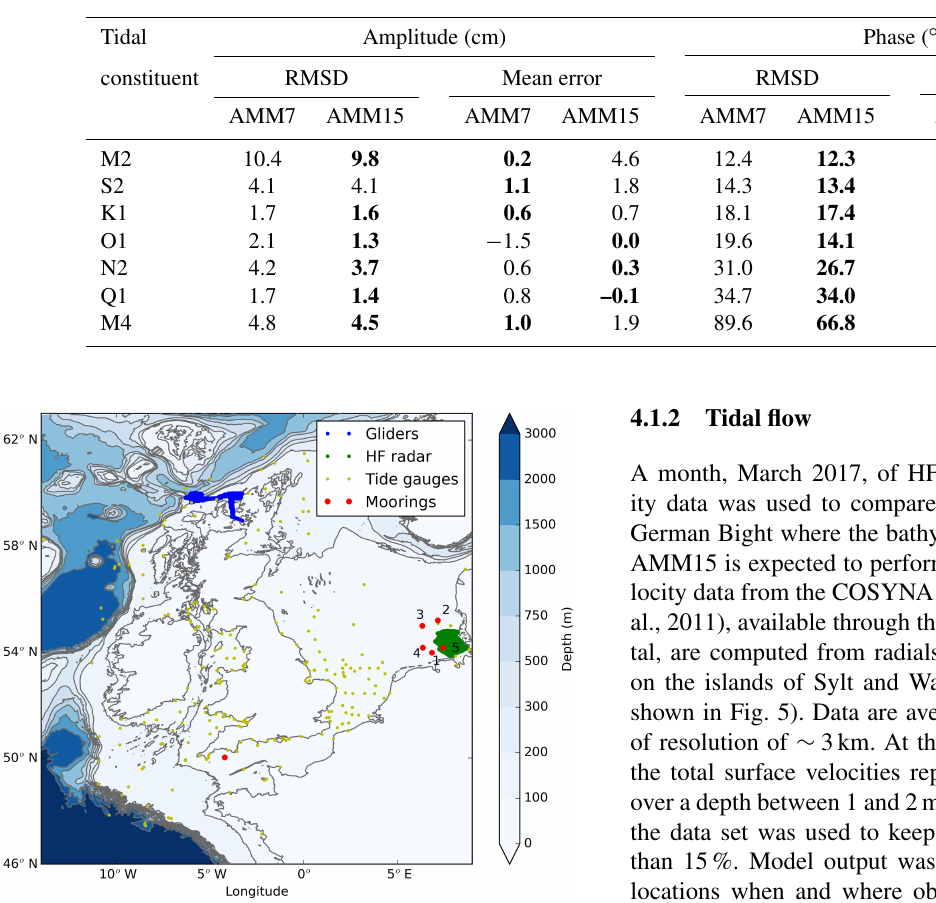
Table 8. RMSD and bias of the tidal amplitude and phase of the prevalent tidal constituents. The values are means over 292 tide gauges for both AMM7 and AMM15. The values in bold indicate an improvement.